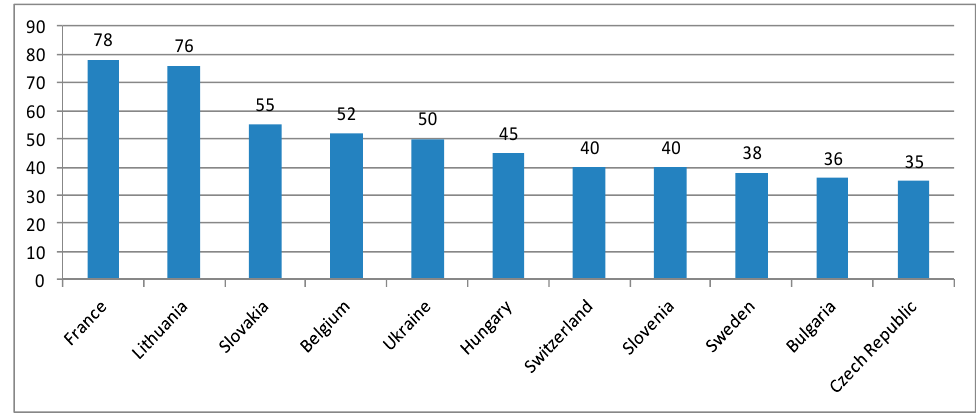
Figure 10. Share of nuclear energy in electricity production in 2018 (in terms of percentage) [47].